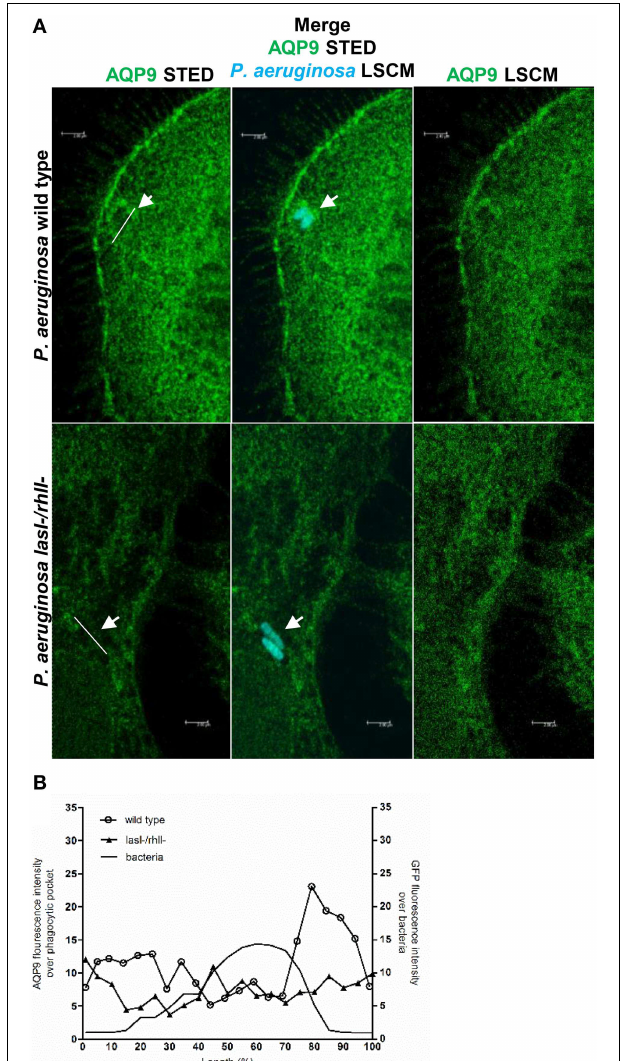
FIGURE 6 | Nanoscale visualization of AQP9 in macrophages during P. aeruginosa infections. (A) Macrophages were infected with GFP-labeled (cyan) wild type P. aeruginosa or the lasI-/rhlI- mutant or non-infected (not shown). Cells were stained for non-ingested P. aeruginosa (not shown), and AQP9 (green), and analyzed by STED. Bacteria shown at these images were completely ingested (cyan). White arrows points to pocket-like AQP9 accumulation around completely ingested wild type bacteria. Bar 2 µ m. (B) Mean AQP9 intensity profiles over phagocytic pockets and mean GFP intensity profile over bacteria from representative images (A) measured as indicated by the white